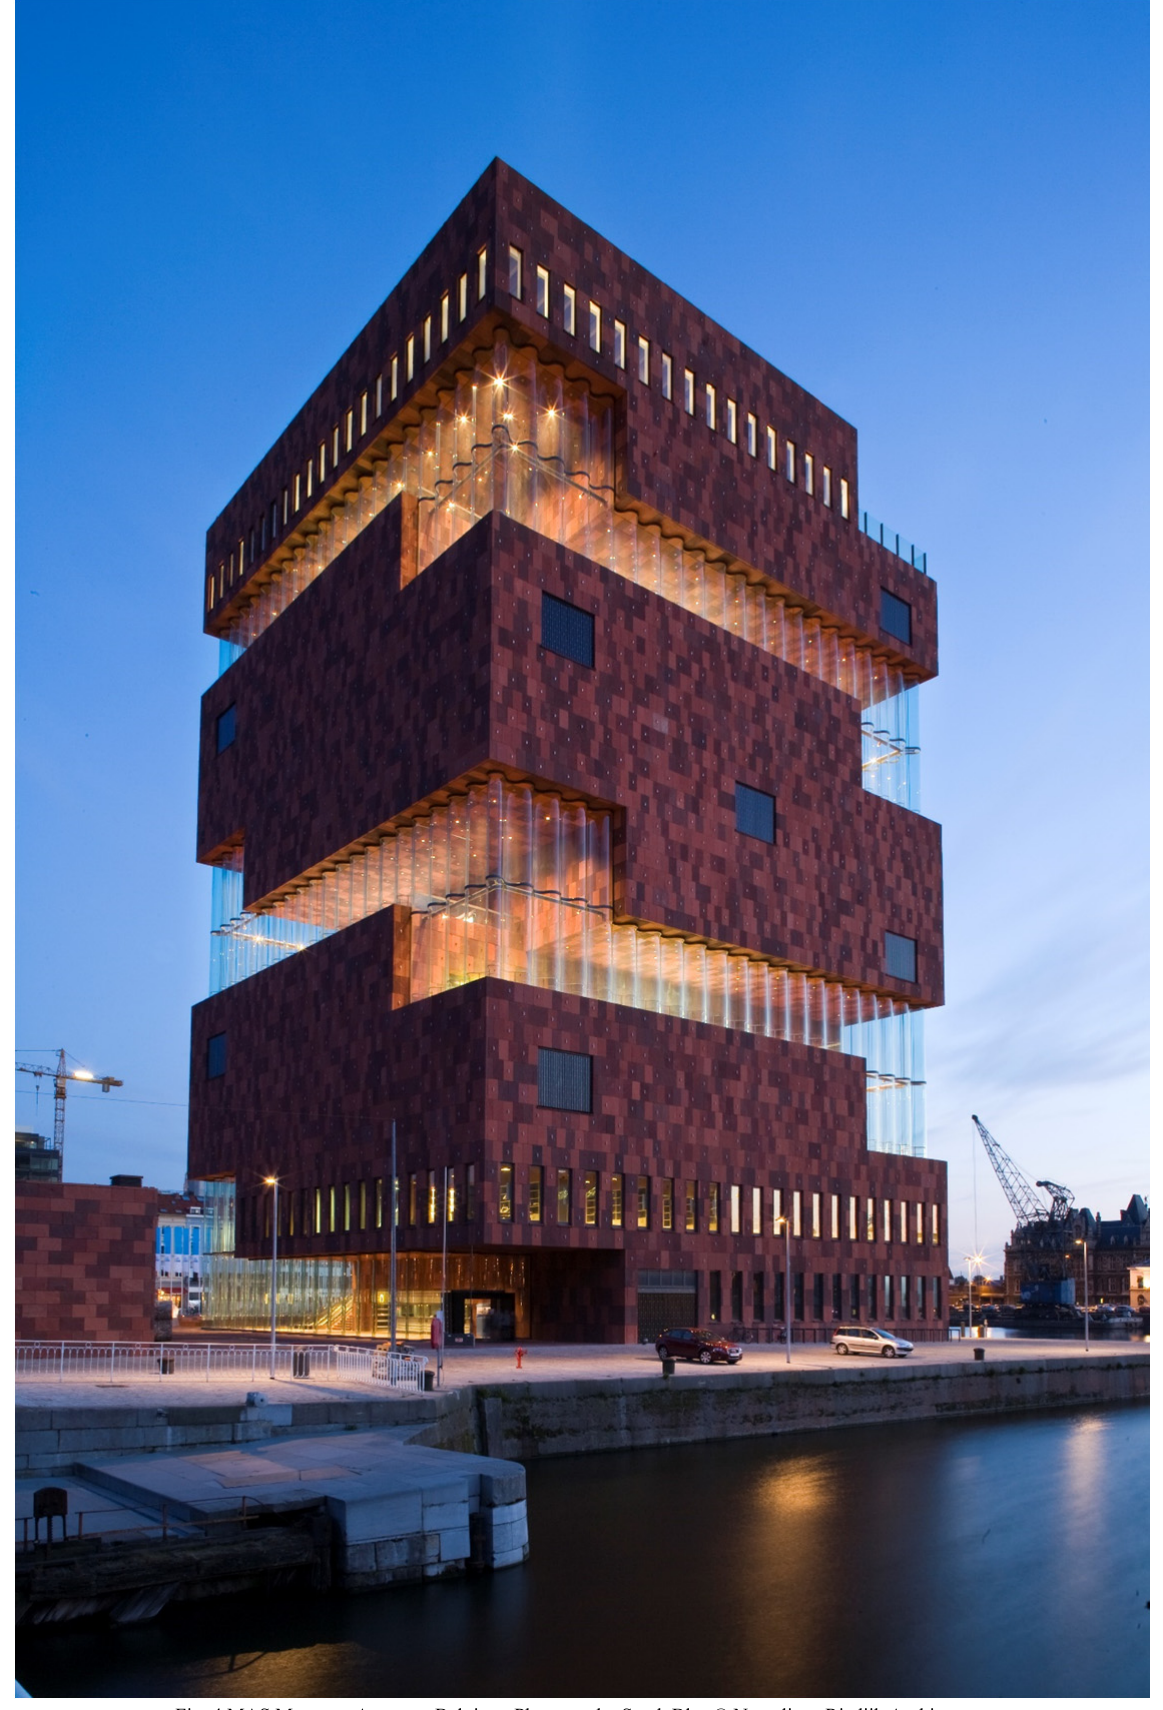
Fig. 4 MAS Museum, Antwerp, Belgium. Photography Sarah Blee © Neutelings Riedijk